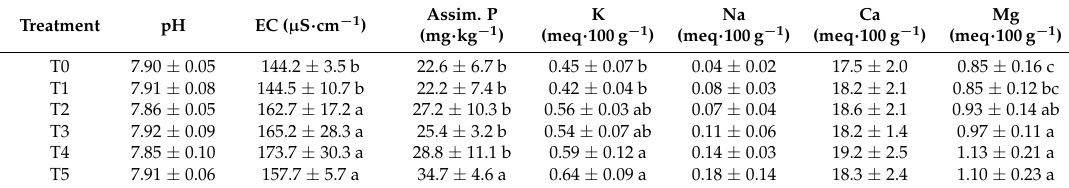
Table 3. Physicochemical properties of the soils after the application of the different treatments over a three-year